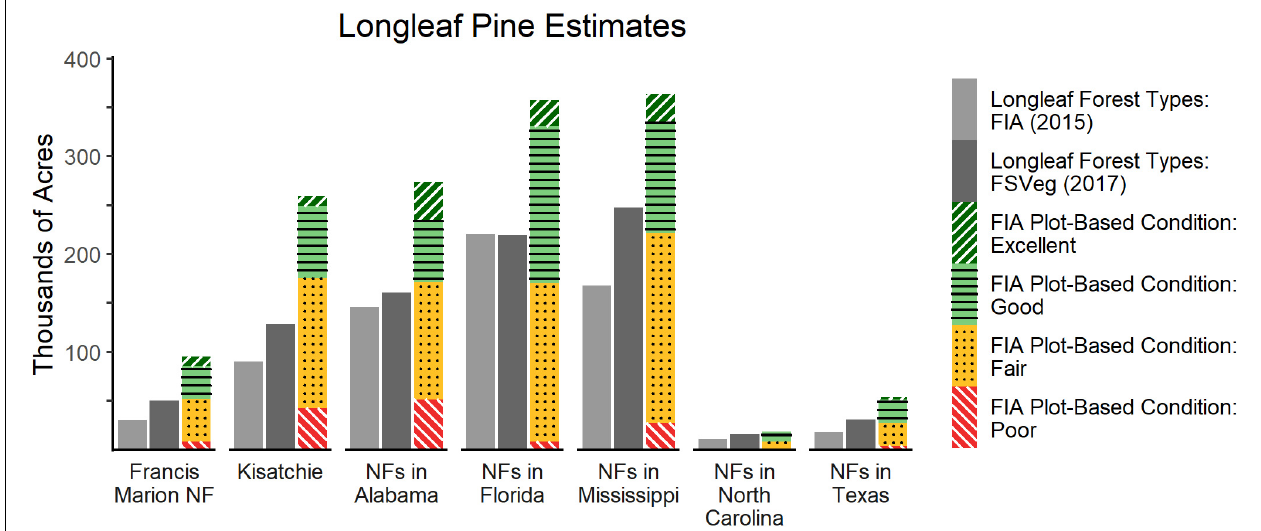
FIGURE 2 | Longleaf pine estimates for Southern Region (R8) National Forests. Longleaf extent based on forest type [FIA/ field sampled vegetation (FSVeg)] does not include any measure for condition and may miss areas that have a longleaf component but were not classified as a longleaf forest type. FIA plot-based condition estimates include any FIA plot that contained at least a single longleaf pine, and therefore may overestimate the extent of longleaf ecosystems in places where longleaf is a minor ecosystem